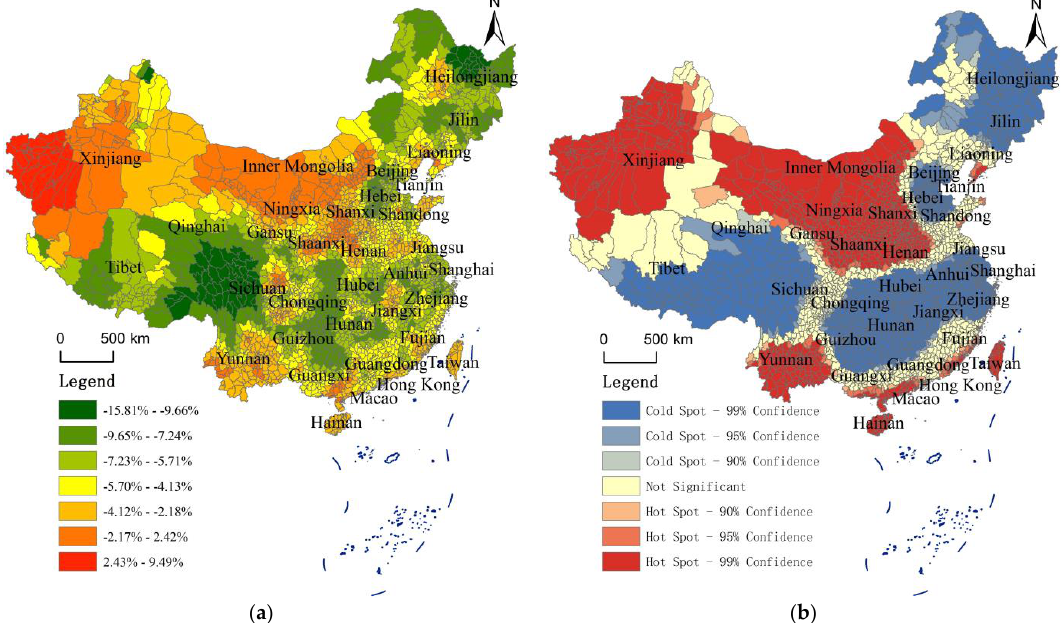
Figure 5. Annual average change rate of AQI in each county from 2014 to 2021 and analysis of its hot and cold spots. ( a ) Annual average change rate of AQI in each county from 2014 to 2021; ( b ) analysis of hot and cold spots of annual average change rate of AQI in each county from 2014 to 2021. Figure 5 well reveals the spatial pattern characteristics of the change trend of the AQI value of each county from 2014 to 2021. It can be seen from Figure 5 that the AQI value in most regions has declined significantly from 2014 to 2021, with the fastest annual decline rate of 15.81%. The provinces with the fastest decline rate are mainly distributed in Tibet, Heilongjiang, Beijing – Tianjin – Hebei Region, Guizhou, Chongqing, and other places. In some provinces, the air quality is poor but has improved significantly in recent years. For example, Beijing-Tianjin-Hebei is a region with serious air pollution, but fortu- nately, its AQI value has declined rapidly, which may be closely related to the